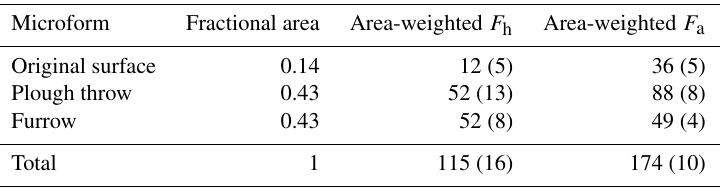
Table 6. Area-weighted heterotrophic peat decomposition ( F h ) and autotrophic ( F a ) fluxes (standard error in brackets) in gCm − 2 yr − 1 averaged over both years